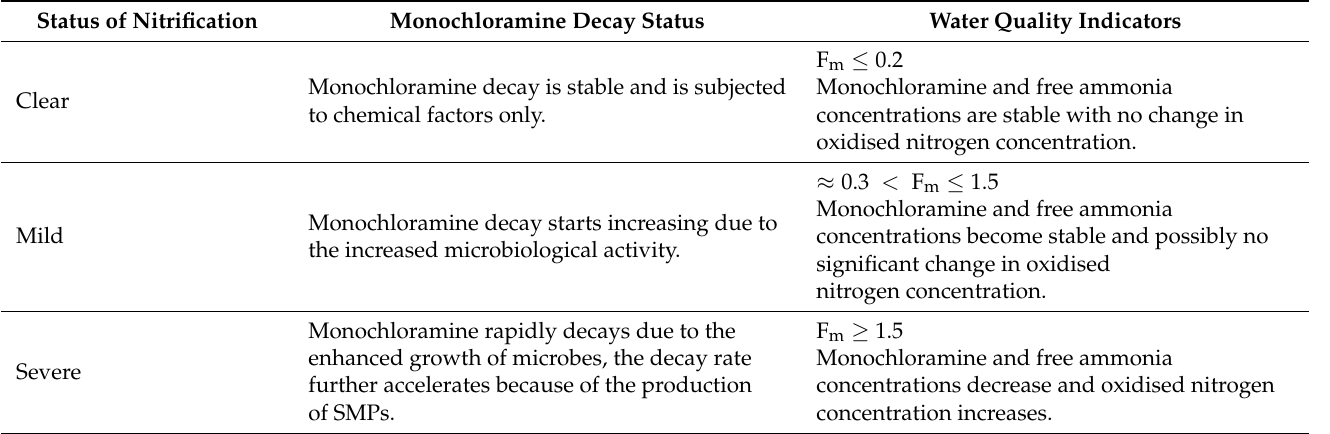
Table 3. Values of microbial decay factor at various stages of nitrification (Source: South Australian Water Corporation’s internal document, based on observed chloramine decay of WTP product and distribution samples over several